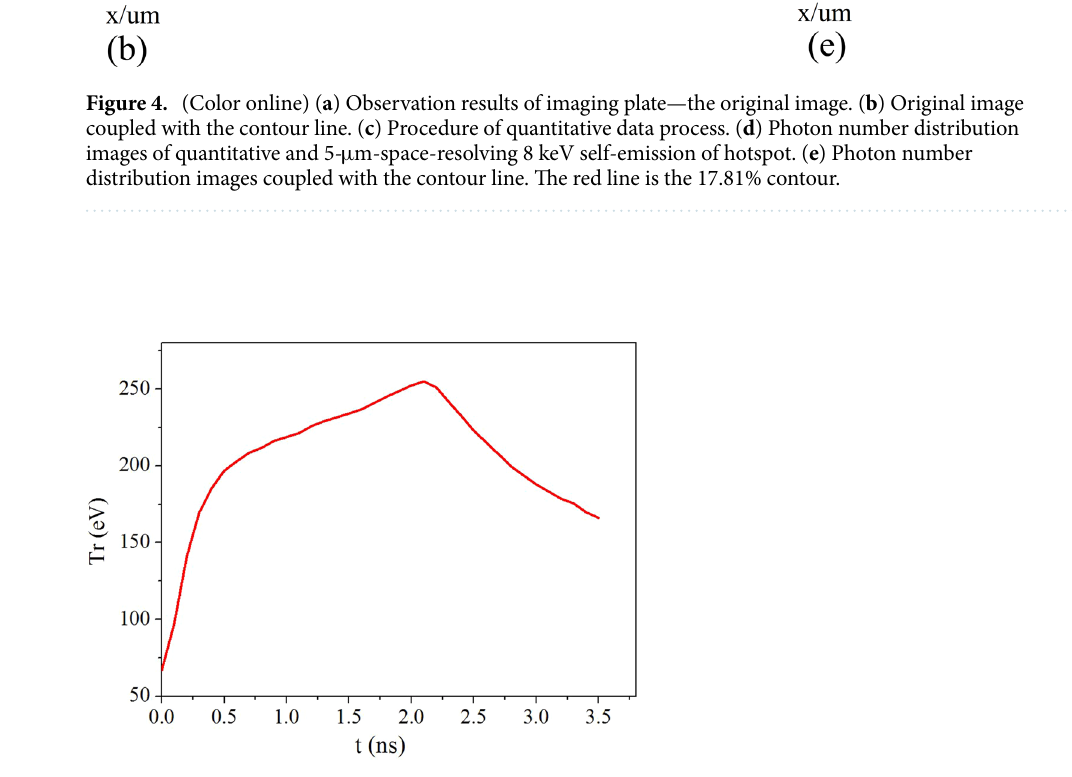
Figure 5. (Color online) Detected hohlraum radiation temperature curve by